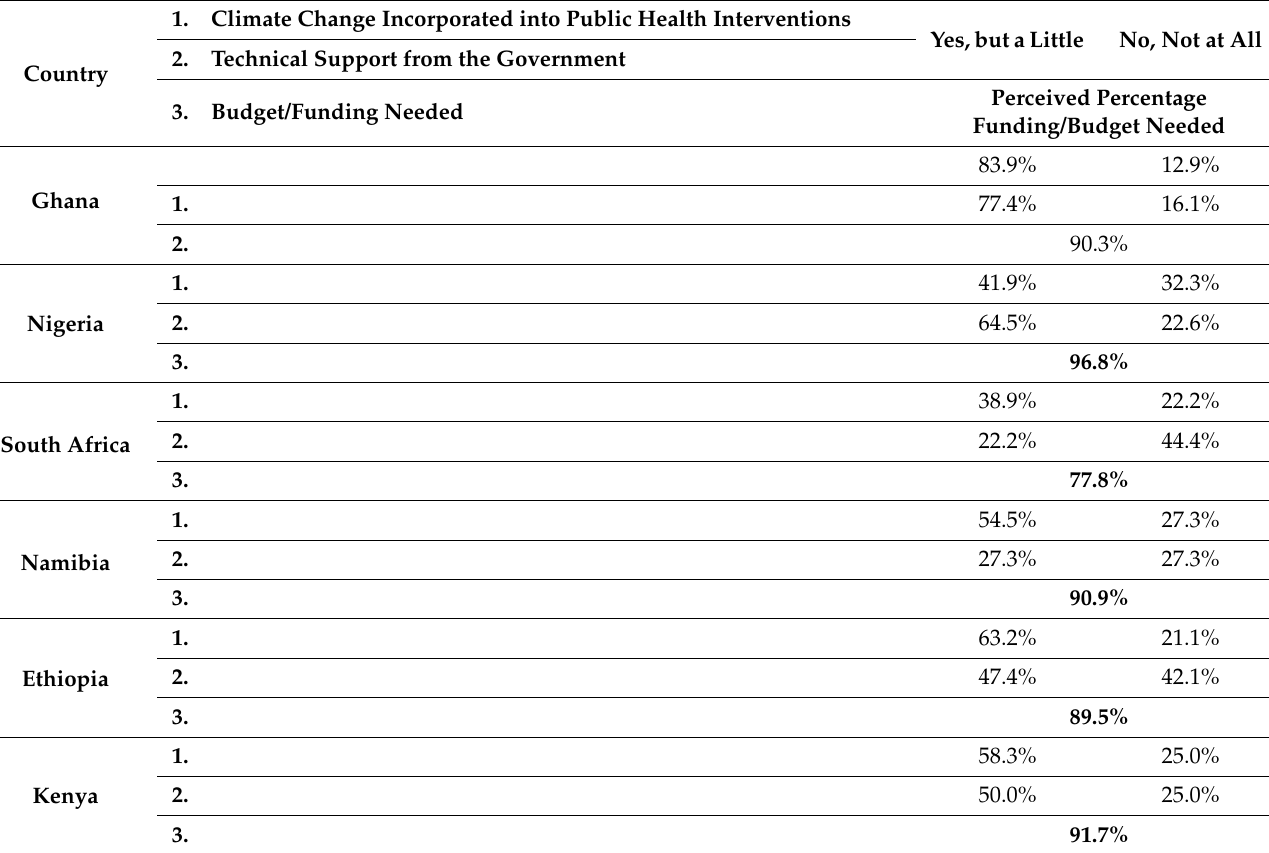
Table 9. Technical support from sampled countries’ government and the needed funding/budget in developing prepared- ness plans and communicating with the public about climate change’s health effects, as perceived by respondents.